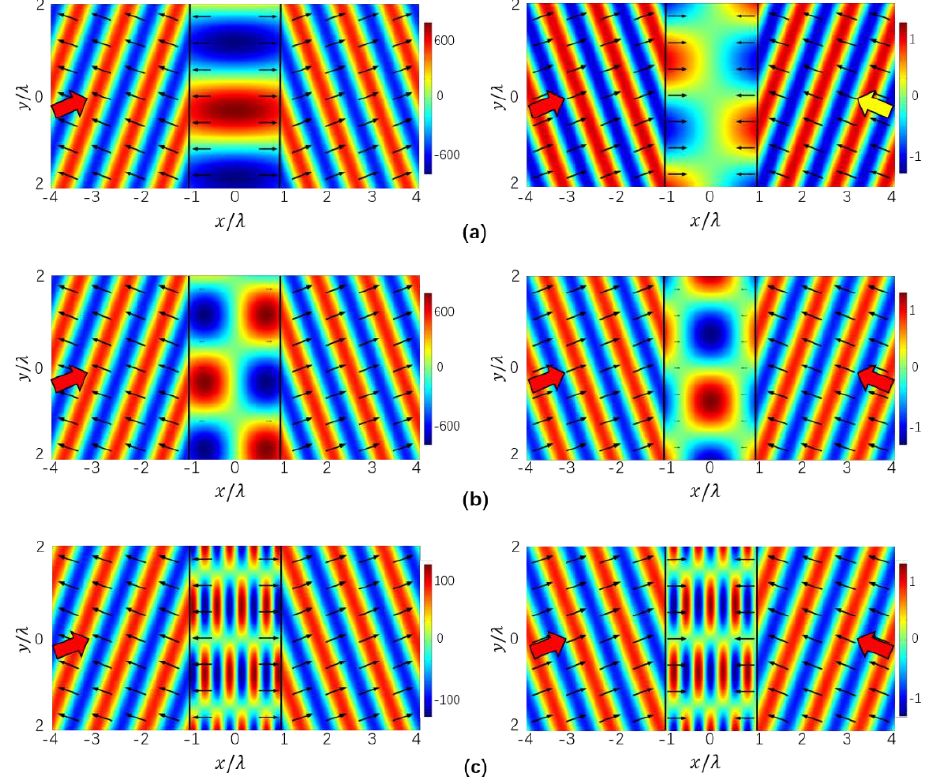
Figure 2. The simulated acoustic fields for laser modes ( left panels) and CPA modes ( right panels). The parameters in ( a ) are ρ r = 0.13 and β r = 1.00, in ( b ) are ρ r = 0.40 and β r = 0.65, and in ( c ) are ρ r = 1.99 and β r = 1.82. In all simulations, the incident wavelength is λ , the width of the PIM slab is d = 2 λ , the incident amplitude is 1 Pa, and the incident angle is set to be 20 ◦ . According to Equation (3), when the m is taken as zero, the density obtained is 0.13 and the bulk compressibility is 1.00. The left panel of Figure 2a shows the total acoustic field pattern when a plane wave is incident from the left side at an incident angle of 20 ◦ , as shown by the red arrow. The total field far exceeds the intensity of the incident field (refer to the color bar) and the distribution is symmetric about the line x = 0. Thus, this is consistent with the distribution pattern of the even acoustic laser mode. The right panel of Figure 2a gives the acoustic field distribution when two waves of opposite phase are incident from the left and right sides with the identical angle indicated by the red and yellow arrows, respectively. The absence of any acoustic scattering in the background media indicates that the coherent incident waves are completely absorbed in the PIM slab structure by the effect of interference as well as material absorption. Additionally, the results show that the amplitude distribution is asymmetric with respect to the line x =